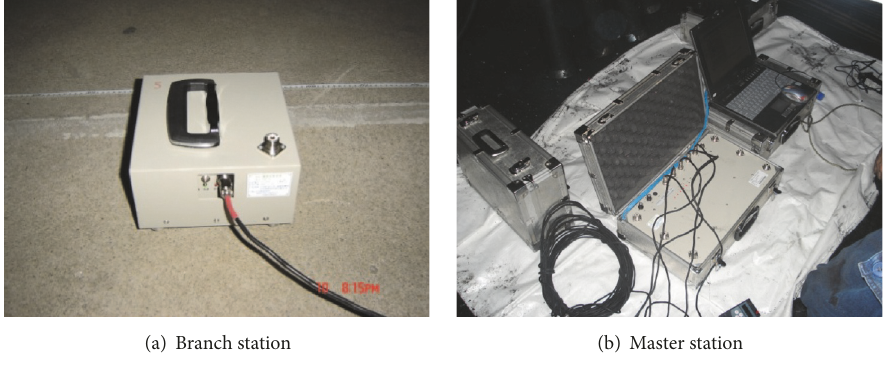
Figure 5: TDS-6 MMS system.